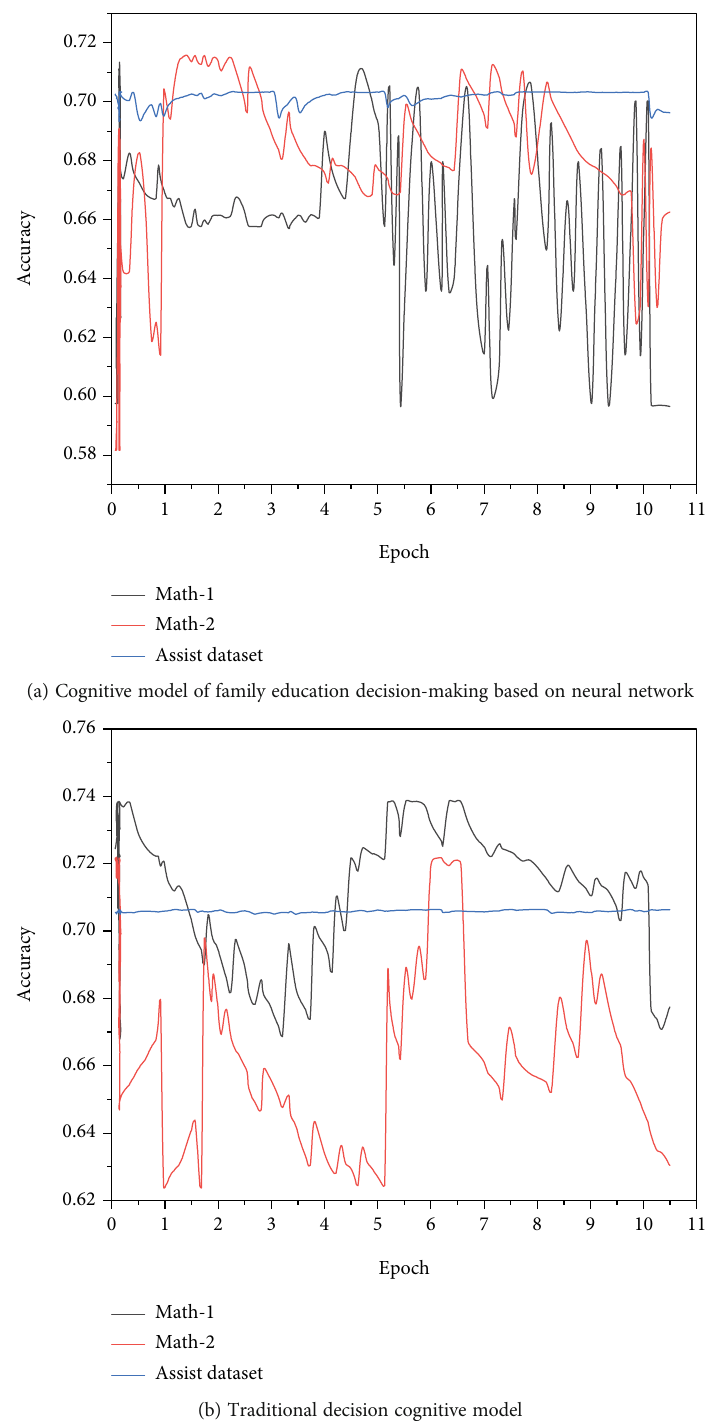
Figure 6: Prediction accuracy of di ff erent models on data